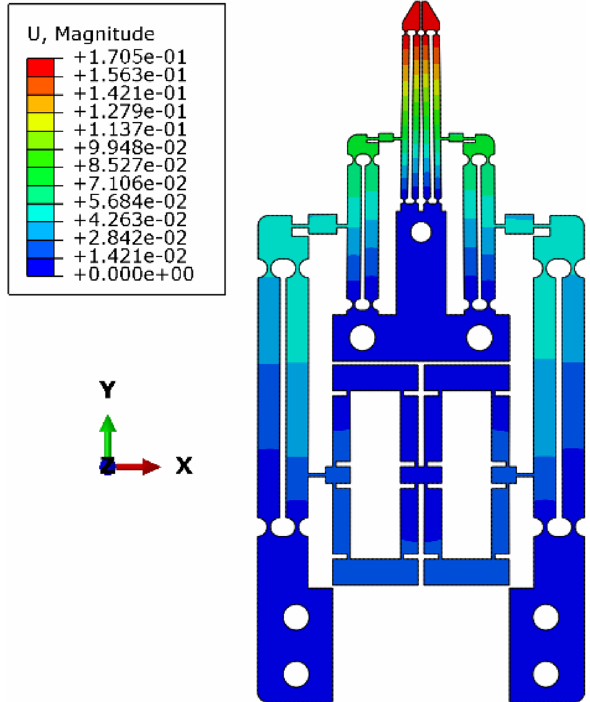
Fig. 3 FEA analysis diagram of the microgripper: displacement nephogram of microgripper